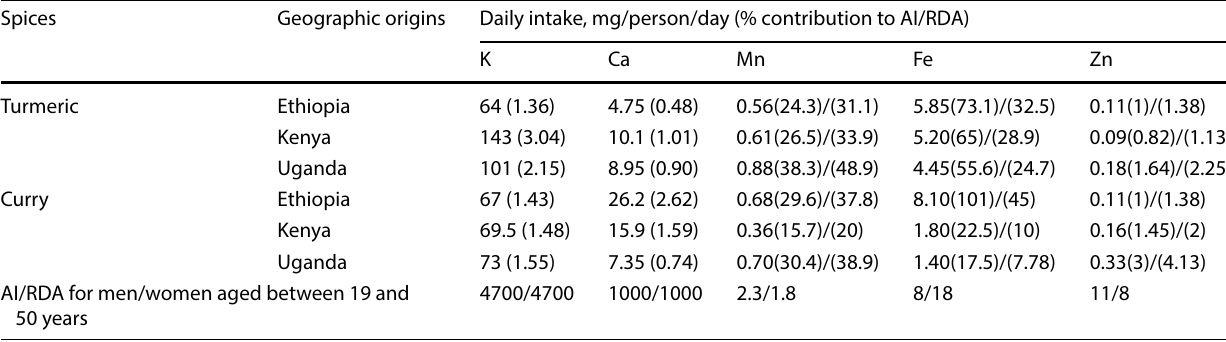
Table 3 Percentage contribution to adequate intake (AI) or recommended dietary allowance (RDA) through the daily consumption of 5 g turmeric and 4 g curry powder by men/women aged between 19 and 50 years